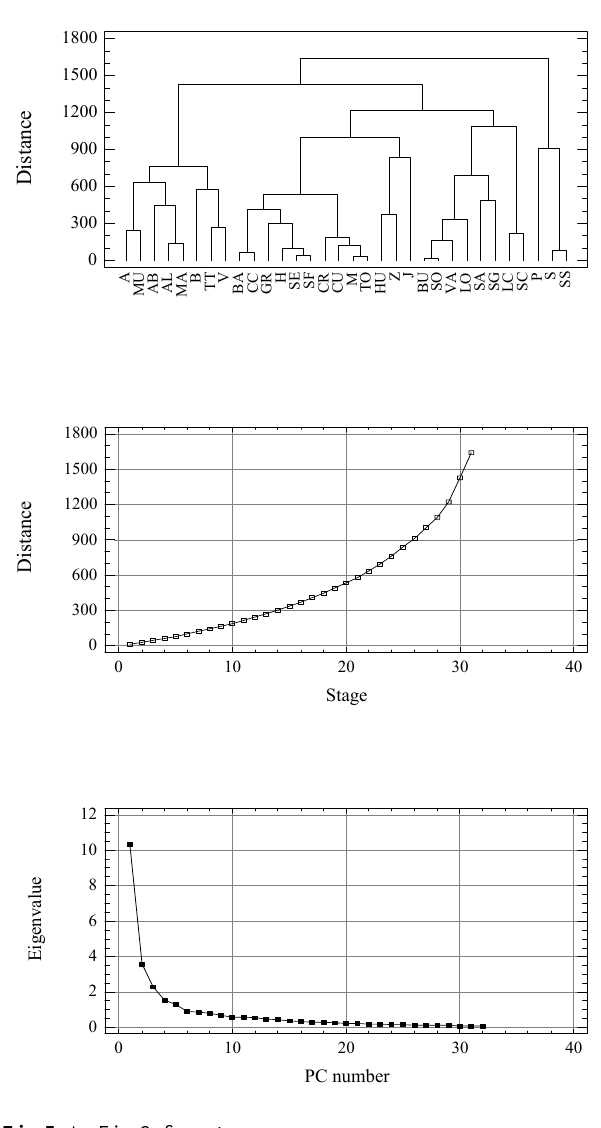
Fig. 5. As Fig. 2, for autumn.